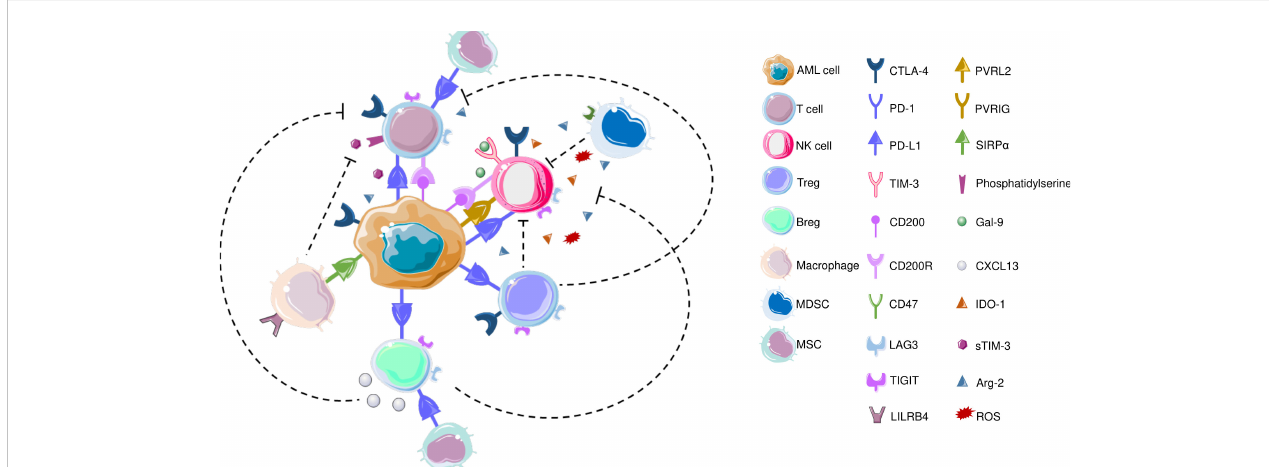
FIGURE 2 CTLA-4, which is also expressed on T cells and NK cells is the fi rst ICP that is reported to be commonly overexpressed in AML to inhibit T cell responses. In terms of T cells, increased frequency of PD-1+CD4+ T cells as well as PD-1+/CD8+ cells co-expressing TIM3 or LAG3 were reported in AML patients ’ bone marrow samples. LSCs also secrete Gal-9 that leads to the elimination Th1 effector cells. LILRB4 is expressed on monocytic leukemic cells and interact with T cells to alter their function. CD200 is also expressed on AML cells that engage in CD200R on T cells and NK cells. Similar to T cells, PD-L1 expression has been detected on Bregs in AML patients. Recently, blocking PD1/PD-L1 axis along with inhibiting CXCL13 has been increased chemotherapeutic ef fi cacy, and CXCL13 has been suggested as a novel ICP; TIGIT is also expressed on BREGs, though both these fi ndings are yet to be con fi rmed in AML BM samples. TAMs express CD47 that protects phagocytosis of AML LSCs. AML: acute myeloid leukemia; Arg-2: Arginase 2; Breg: B regulatory cell; CTLA-4: Cytotoxic T-lymphocyte antigen-4; CXCL-13: CXC chemokine ligand 13; Gal-9: Galectin-9; IDO-1: Indoleamine 2,3- dioxygenase; LAG3: Lymphocyte-activation gene 3; LILRB4: Leukocyte immunoglobulin like receptor B4; MDSC: myeloid-derived suppressor cell; MSC: Mesenchymal stem cell; NK cell: Natural killer cell; PD-1: Programmed death – 1; PD-L1: Programmed death ligand 1; PVRIG: Poliovirus receptor related immunoglobulin domain containing; PVRL2: Poliovirus receptor-related 2 (Nectin-2); ROS: Reactive oxygen species; SIRP a : Signal regulatory protein a ; sTIM-3: soluble TIM-3; TIGIT: T cell immunoreceptor with Ig and ITIM domains; TIM-3: T-cell immunoglobulin and mucin domain 3; Treg: T regulatory cell; VISTA: V-domain Ig suppressor of T cell